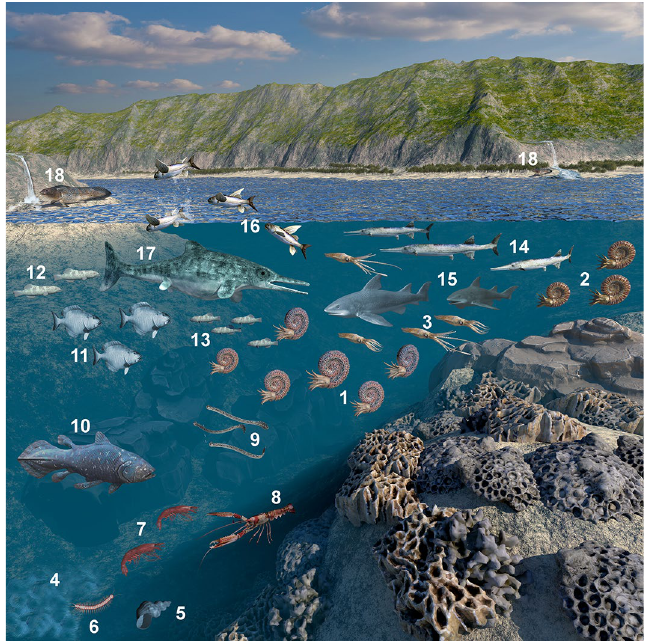
Figure 7. Reconstruction of the palaeoenvironment and members of the Carnian Polzberg palaeobiota. 1 Austrotrachyceras minor , 2 Austrotrachyceras haberfellneri , 3 Phragmoteuthis bisinuata , 4 Halobia rugosa , 5 caenogastropod, 6 Palaeoaphrodite , 7 Antrimpos , 8 Platychela trauthi , 9 conodontophorida, 10 “Coelacanthus” lunzensis , 11 Polzbergia brochatus , 12 Habroichthys gregarius , 13 Nannolepis elegans , 14 Saurichthys calcaratus , 15 Acrodus , 16 Thoracopterus niederristi , 17 predator X, 18 Tellerodus sturii . Figured members of palaeobiota not to scale. Artwork based on Fig. 5 by AL using CorelDRAW X7; www. corel draw. com. Final artwork by 7reasons; www. 7reas ons.